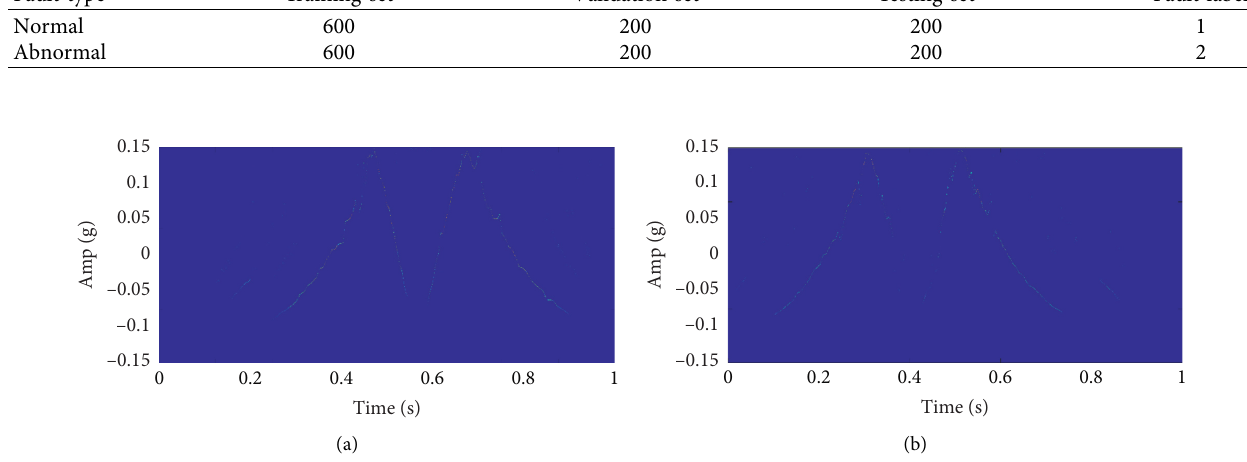
Figure 9: Time-frequency images of loudspeaker signals: (a) normal; (b) abnormal.